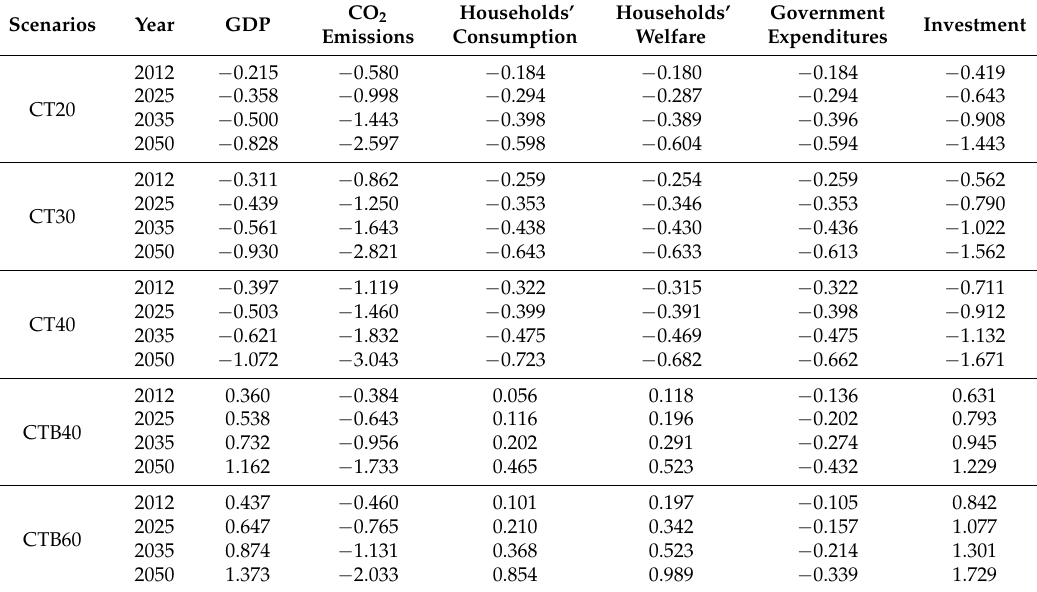
Table 4. The changes in macroeconomic indicators under different scenarios between 2012–2050 (%) (compared with the BAU